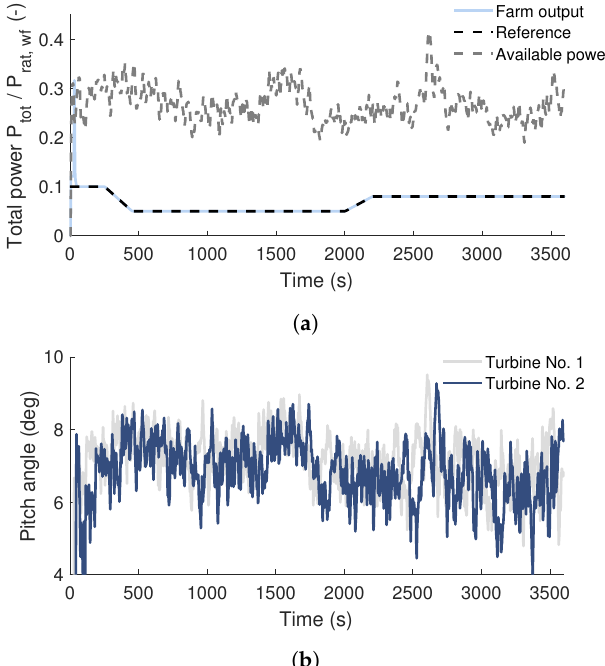
Figure 3. Simulated operation of two-turbine array used for comparison with DFP. Shown are ( a ) total farm power and ( b ) blade pitch